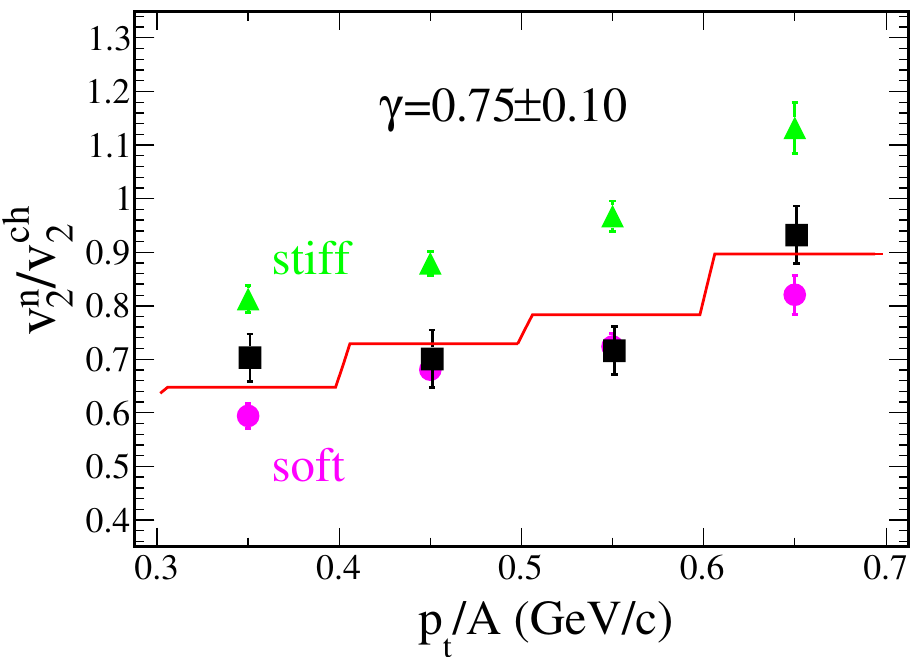
Figure 5. Elliptic flow ratio of neutrons over all charged particles for central ( b < 7.5 fm) collisions of 197 Au+ 197 Au at 400 MeV/nucleon as a function of the transverse momentum per nucleon p t / A . The black squares represent the experimental data; the green triangles and purple circles represent the QMD predictions for stiff ( γ = 1.5) and soft ( γ = 0.5) power-law exponents of the potential term, respectively. The solid line is the result of a linear interpolation between the predictions, weighted according to the experimental errors of the included four bins in p t / A and leading to the indicated γ = 0.75 0.10. Figure taken from ±